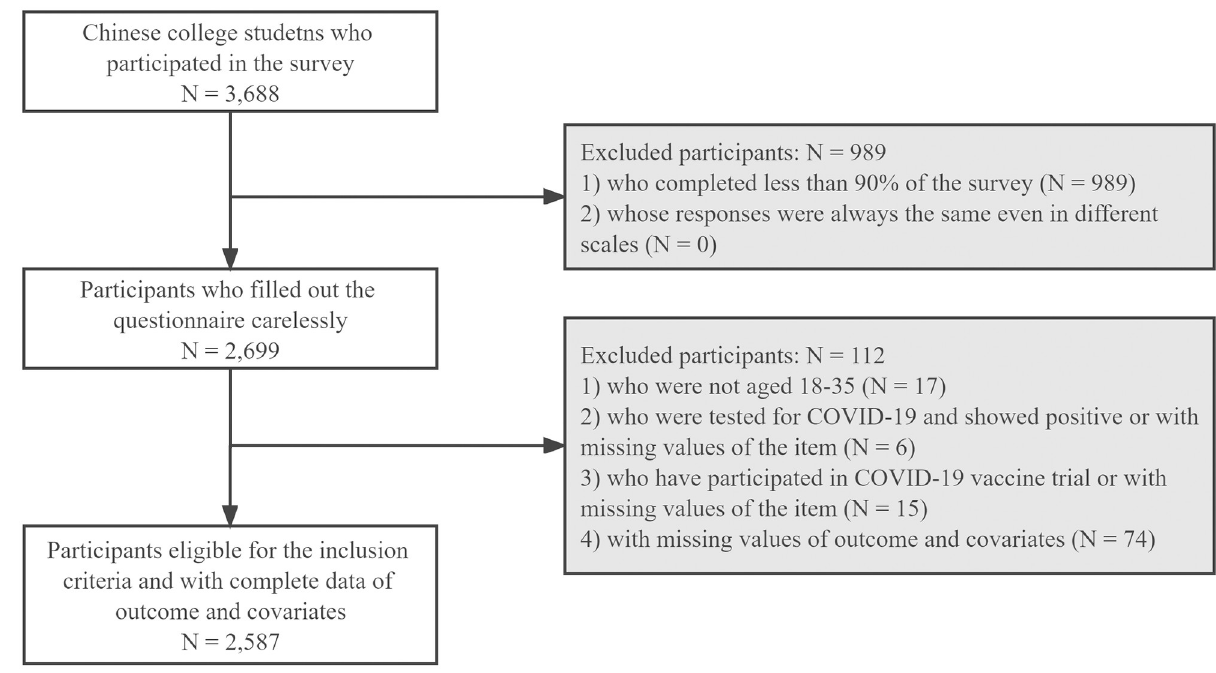
Fig 2. Flow chart population included in our analysis (N =